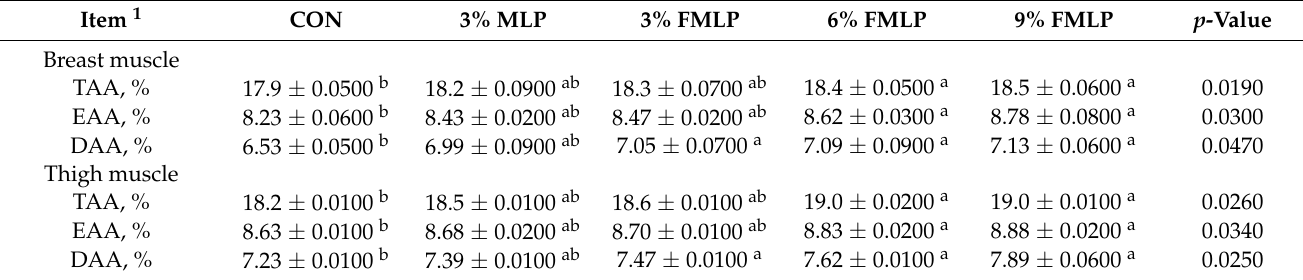
Table 10. Effects of FMLP on amino acid profile in breast and thigh muscle of broilers.